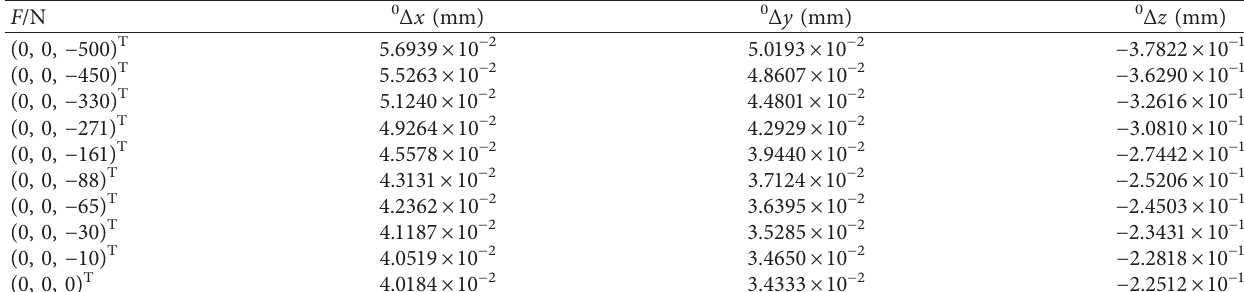
Table 3: Settings of the end load for parameters identification.